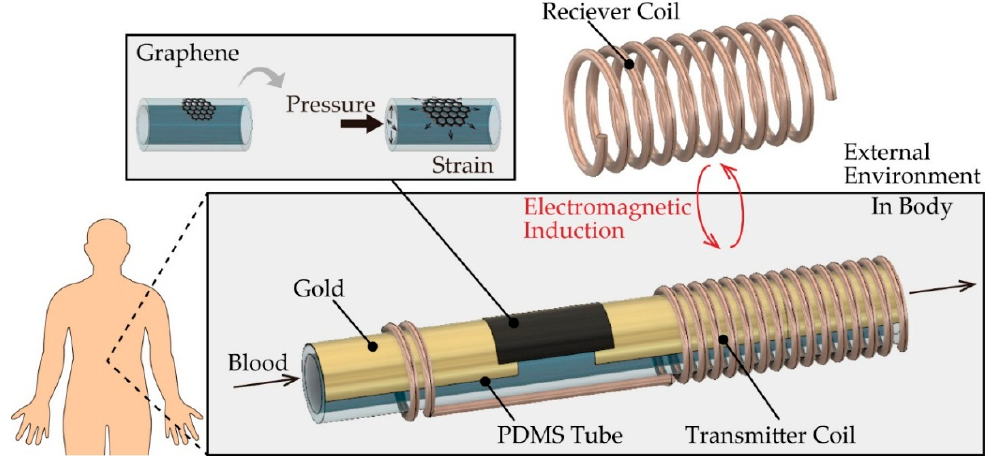
Figure 1. Conceptual illustration of the graphene-based wireless tube-shaped pressure sensor.